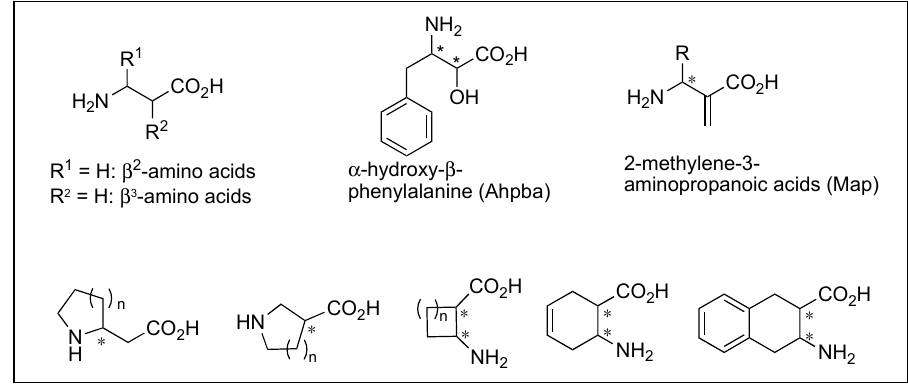
Figure 7. Structures of β -amino acids (upper) and alicyclic β -amino acids (lower). * Chiral. In morphiceptin analogs that are similar to the structure of EMs, incorporation of cis -2-aminocyclopentane carboxylic acid ( cis -2-Acpc) into position 2 retained the activ- ity and selectivity of parent peptides for MOR due to enough separation of Tyr 1